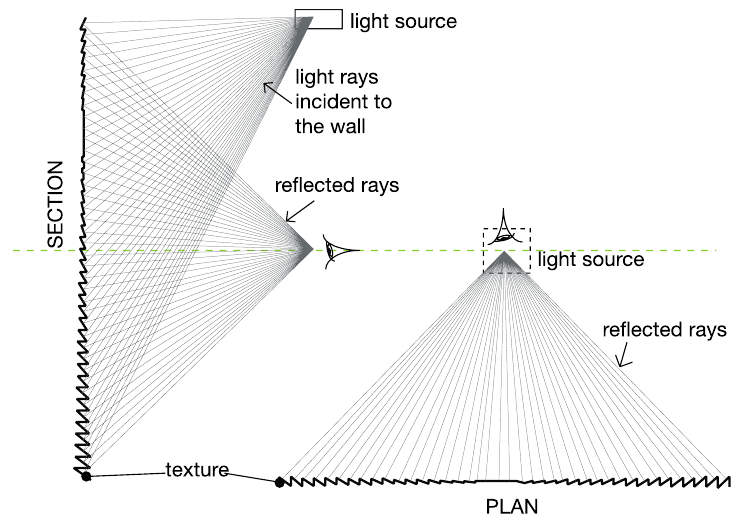
Figure 4. Active wall texture redirecting the reflected light rays towards the focal point.